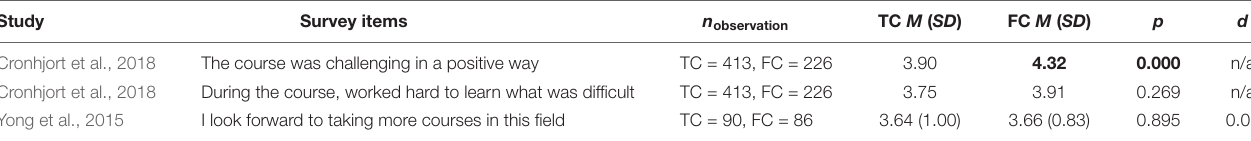
TABLE 9 | Survey results: Preference for challenges by effect size.